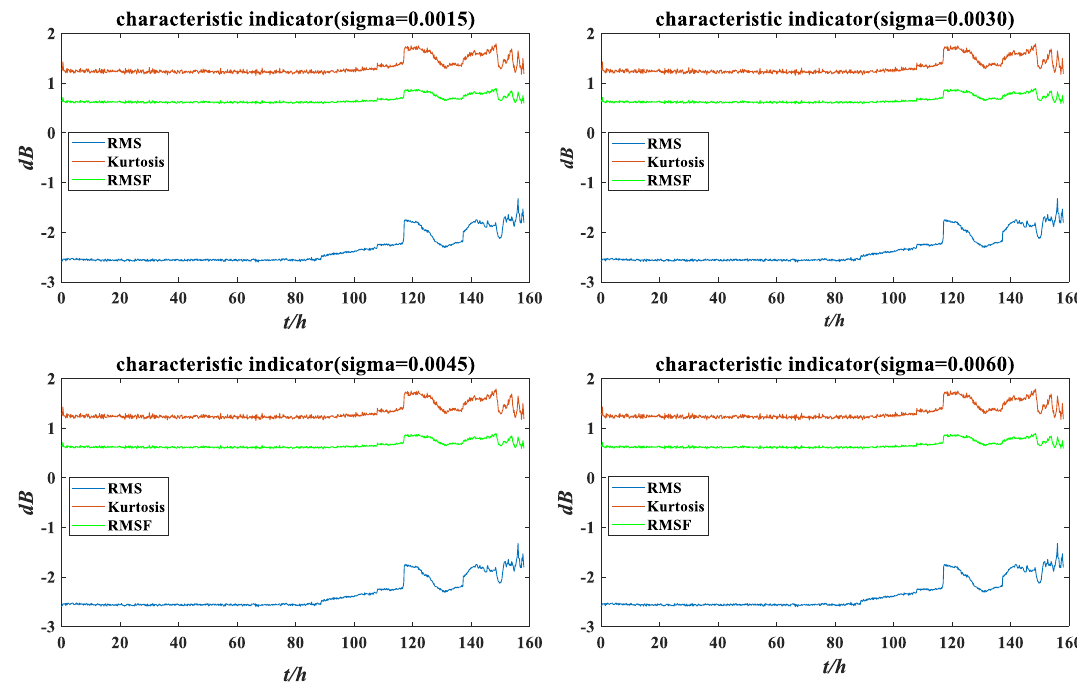
Figure 22. The characteristic indicators under different perturbation intensities.